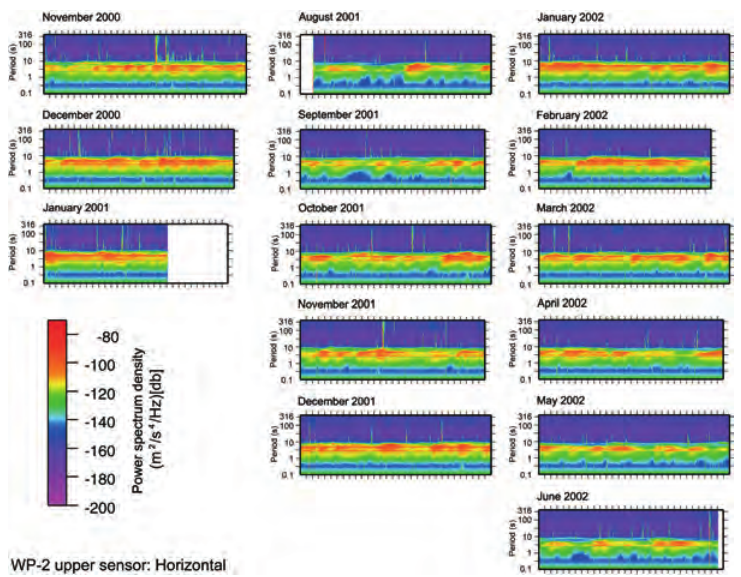
Fig. 7d. Running spectra of the records from the deep-sea borehole observatories. Each spectrum is calculated with a moving time window for a total of one hour record. Here the spectra are for the horizontal component of WP-2. A total of 417 days of continuous data were retrieved from WP-2. There is little change in noise levels above 10 s period. Many earthquakes are visible on the running spectra in periods greater than 10 s. Small tem- poral variations (maximum fluctuation is 10 dB) of noise levels for periods around a few seconds are